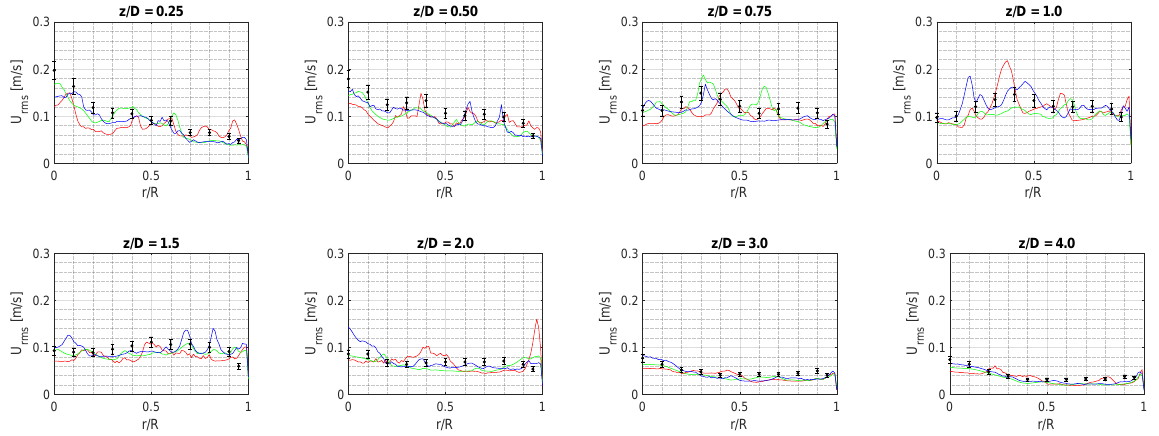
Figure 16. RMS of tangential velocity at several cross sections for different mesh resolutions (red: Mesh 1, green: Mesh 2, blue: Mesh 3, dots: experiments).